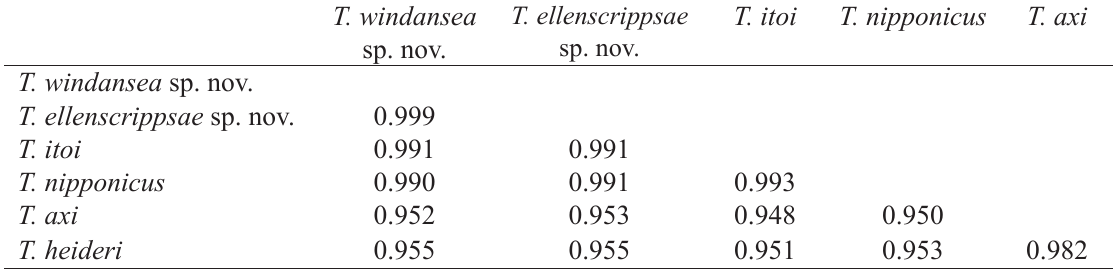
Table 4. Comparison of similarities between 18S gene fragments in species of Trilobodrilus Remane, 1925. For accession numbers of the used sequences see Table 3.